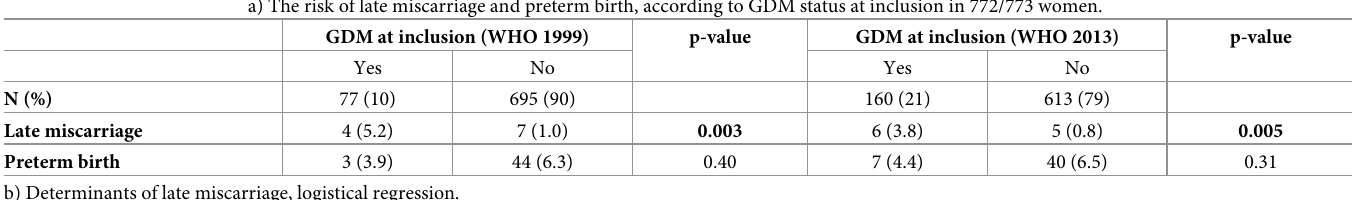
Table 2. a) The risk of late miscarriage and preterm birth, according to GDM status at inclusion in 772/773 women. b) Determinants of late miscarriage, logistical